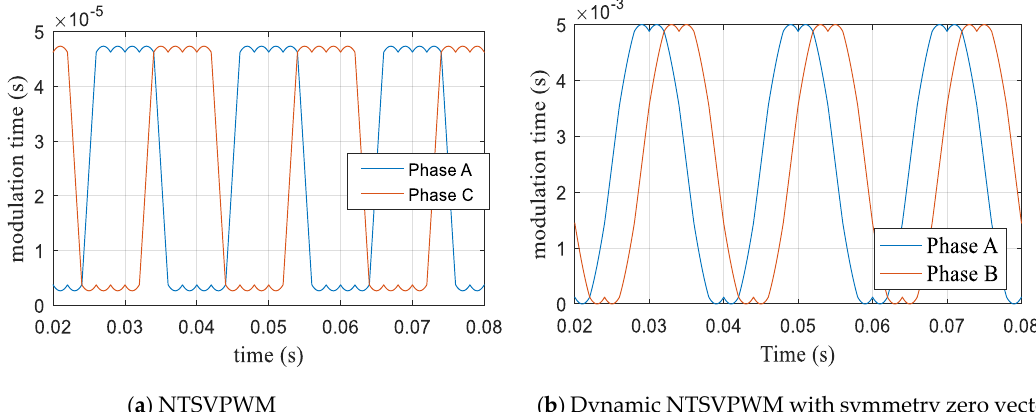
Energies 2019 , 12 , x FOR PEER REVIEW Figure 16. Modulation time curve based on NTSVPWM at m = 1.1. Figure 16. Modulation time curve based on NTSVPWM at m = 1.1. Figure 16. Modulation time curve based on NTSVPWM at m = 1.1.